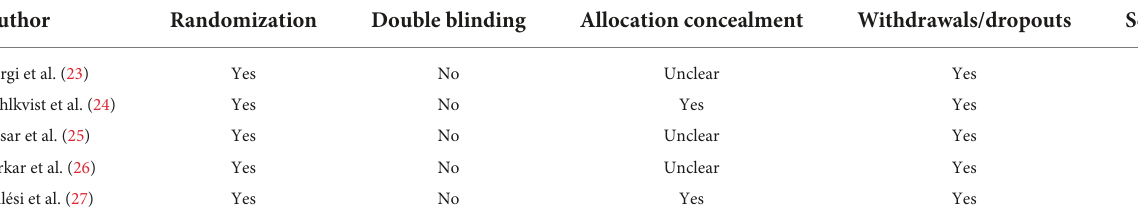
TABLE 2 Assessment of methodological quality of included studies.